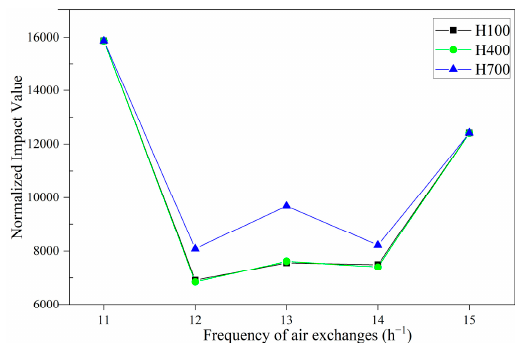
Figure 16. Normalized analysis.